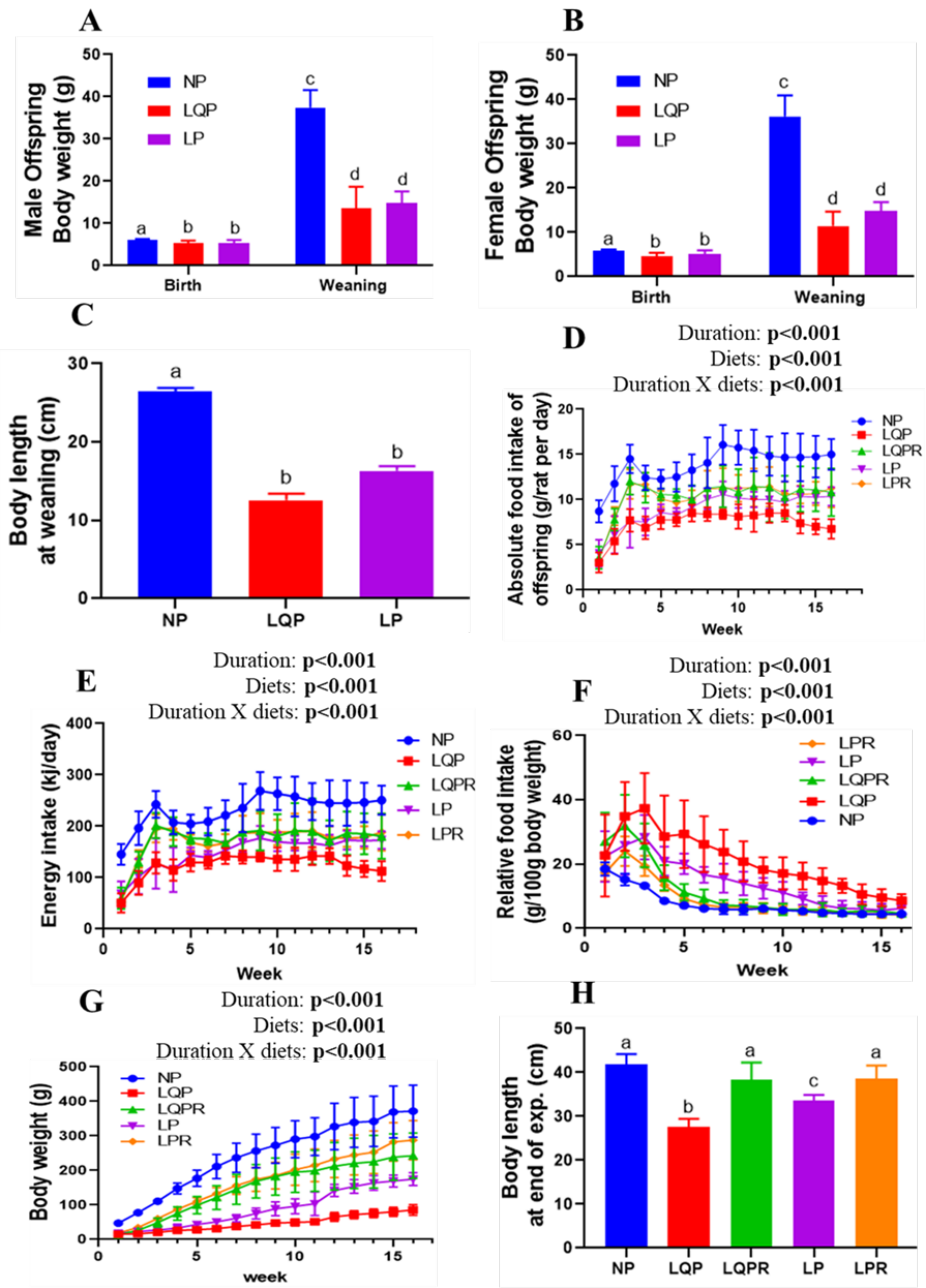
Figure 3. Effect of maternal protein restriction followed by rehabilitation on bodyweight, food intake, and body length in the offspring: ( A ) bodyweight of the male pups at birth (NP, n = 10; LQP, n = 17; LP, n = 16) and weaning (NP, n = 10; LQP, n = 14; LP, n = 16); ( B ) BWs of the female pups at birth (NP, n = 22; LQP, n = 14; LP, n = 13) and weaning (NP, n = 20; LQP, n = 10; LP, n = 10); ( C ) body length of the pups at weaning (NP, n = 12; LQP, n = 8 – 12, LP, n = 11 – 12); ( D ) absolute food intake (NP, n = 12; LQP, n = 8 – 12, LQPR, n = 11 – 12, LP, n = 11 – 12; LPR, n = 12); ( E ) energy intake; ( F ) relative food intake; ( G ) weekly BWs of the offspring from weaning to the end of the experiment (NP, n = 12; LQP, n = 8 – 12, LQPR, n = 11 – 12, LP, n = 11 – 12; LPR, n = 12); ( H ) body length of the offspring at the end of the experiment ( n = 6 per group). The data were tested using two-way ANOVA and one-way ANOVA. The bars indicate the mean ± SD, and the bars that share different superscript letters differ significantly ( p < 0.05). NP, normal protein; LQP, low-quality protein diet; LQPR; low-quality protein group rehabilitated with the NP diet; LP, low-protein; LPR, low-protein group rehabilitated with the NP diet.